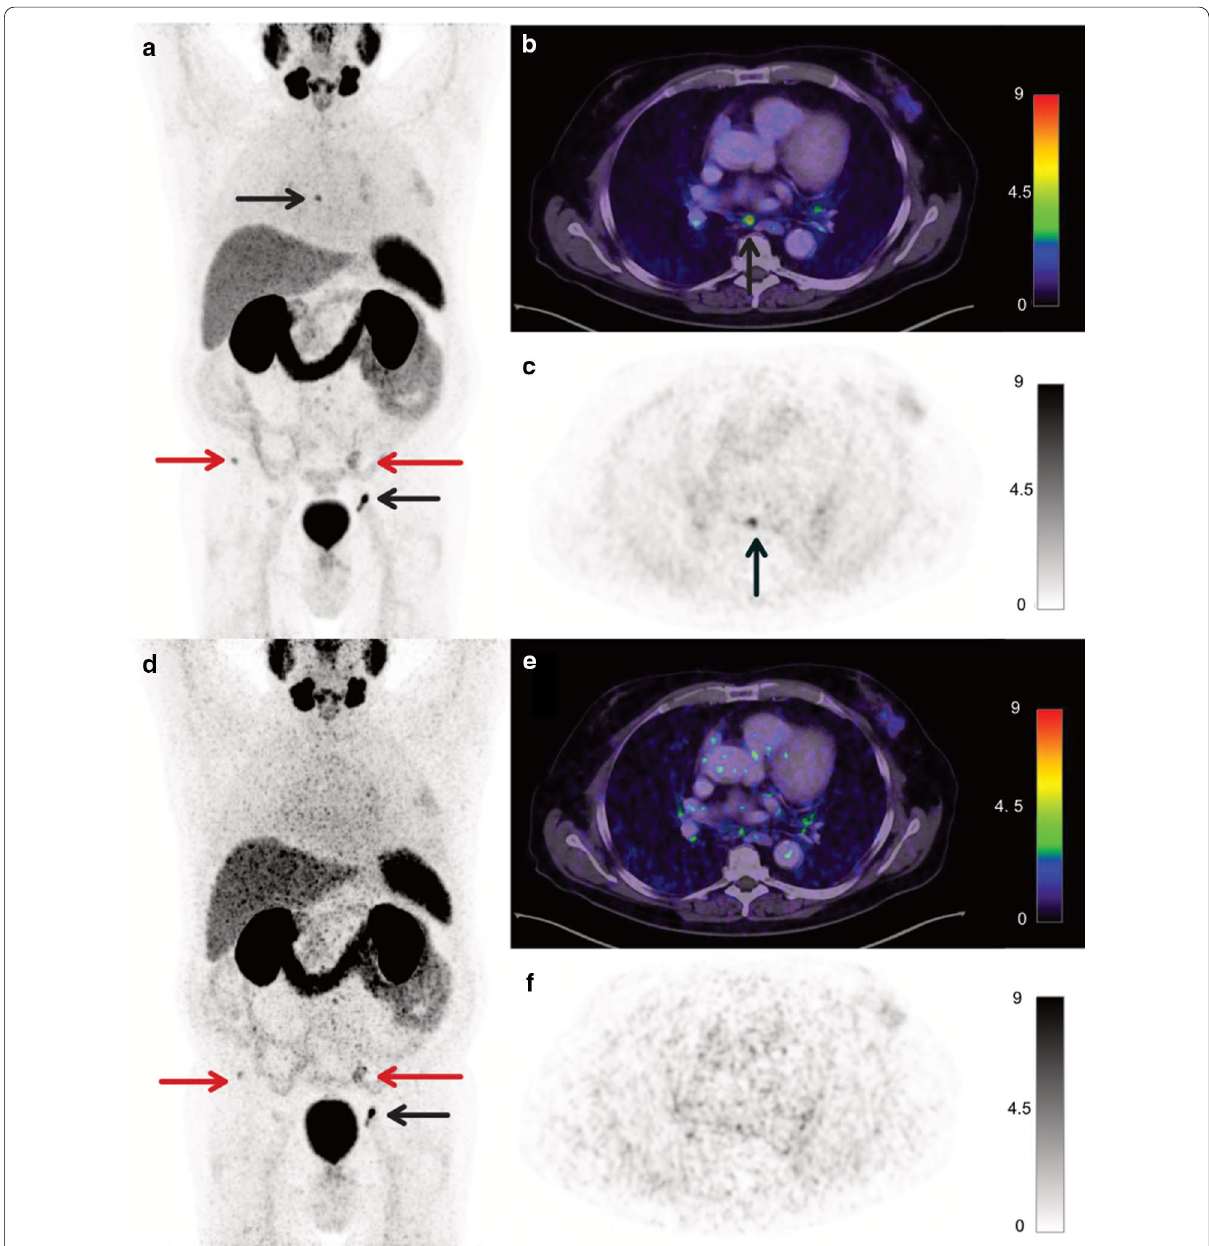
Fig. 1 A 65-years old patient (Pat. ID #7) with second biochemical recurrence after primary prostatectomy and salvage external beam radiation therapy. PSA was 0.6 ng/ml at the time of imaging. a – c show images acquired with the reference acquisition protocol; d – f show images acquired with the reduced acquisition protocol, all reconstructed with OSEM-PSF TOF(4i). Pathological tracer uptake in a mediastinal lymph node visible + on the images acquired with reference protocol ( c , black arrow) was not reproducible with three and a half-fold reduction in scan time duration ( f ). Maximum intensity projection ( a , d ) and axial [ 68 Ga]Ga-PSMA-11 PET/CT slices ( b , c , e , f ) show pelvic and extrapelvic lymph node metastases (black arrows) and bone metastases (red